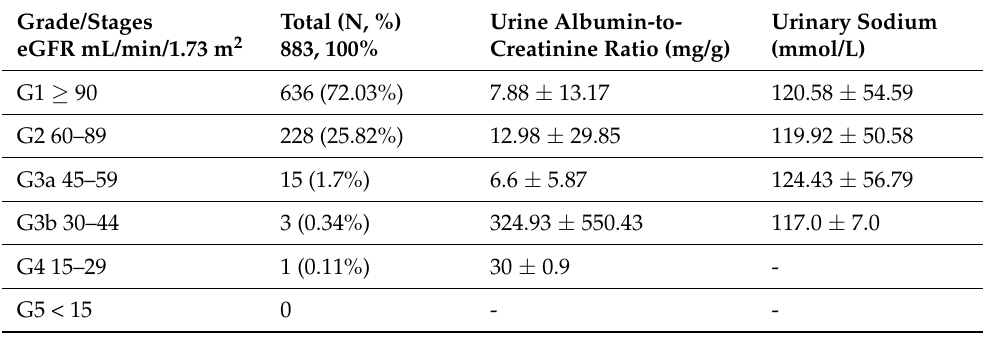
Table 2. Stages of CKD according to the eGFR in the sample of subjects from the SEPHAR IV survey. Legend: eGFR—estimated glomerular filtration rate, G—grade, N—number, %—percentage.